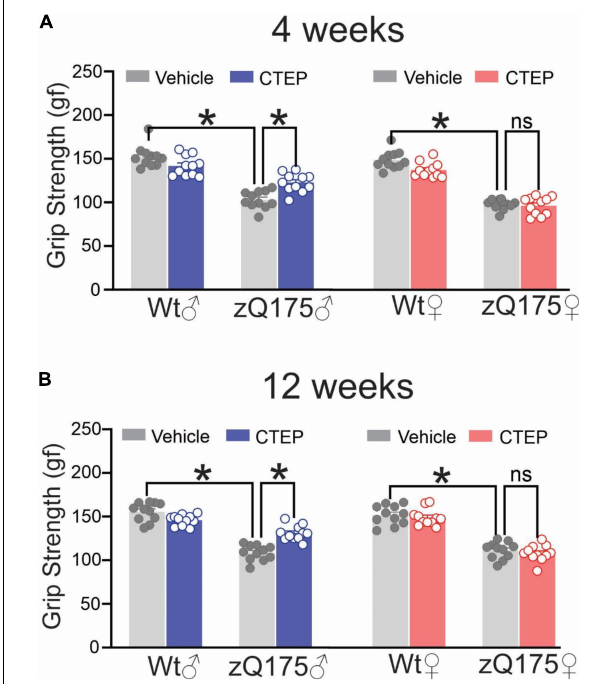
FIGURE 1 | Effect of chronic administration of CTEP on grip strength in male and female zQ175 mice. Mean ± SEM of grip strength [gram-force (gf)] after 4 weeks (A) and 12 weeks (B) of treatment with either vehicle or CTEP (2 mg/kg/48 h) of 12-month-old heterozygous zQ175 (zQ175) and wildtype (Wt) male and female mice ( n = 11 for each group). * P < 0.05 by three-way analysis of variance (ANOVA) and Tukey’s multiple comparisons test.